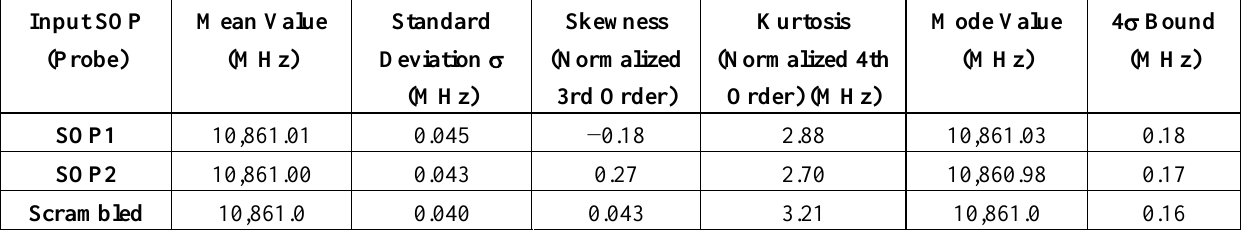
Table 1. Statistics of PDF of Brillouin frequency with different input